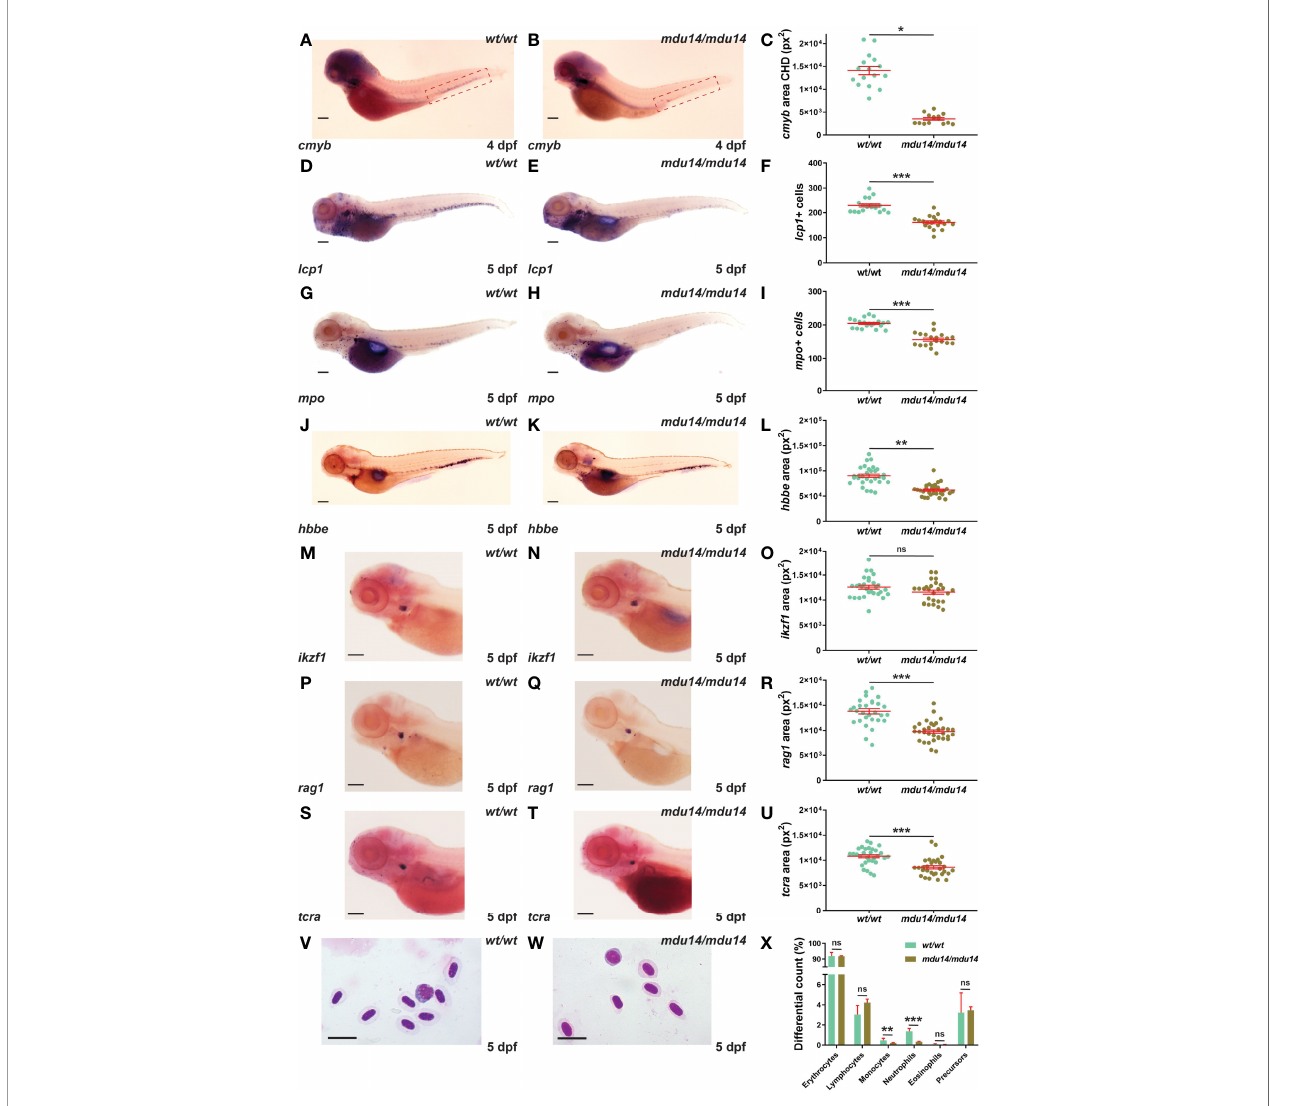
FIGURE 4 | Mutation of crlf3 impacts early de fi nitive hematopoiesis. (A – X) . Homozygous wild-type crlf3 wt/wt ( wt/wt ) and crlf3 mdu14/mdu14 ( mdu14/mdu14 ) embryos were subjected to WISH with cmyb (A, B) at 4 dpf, and lcp1 (D, E) , mpo (G, H) , hbbe (J, K) , ikzf1 (M – N) , rag1 (P, Q) and tcra (S, T) at 5 dpf (scale bar = 200 m m), or underwent blood analysis (V – W) at 5 dpf (scale bar = 10 m m). Individual embryos were assessed for the area of staining of cmyb CHD region (dotted boxes in panels A and B ) (C) , hbbe (L) , ikzf1 (O) , rag1 (R) and tcra (U) , as well as the number of lcp1 + (F) and mpo + (L) cells or for blood differential counts (X) , with mean and SEM in red and statistical signi fi cance indicated (*** p < 0.001, ** p < 0.01, * p < 0.05, ns, not signi fi cant). Welch ’ s correction was used for panels (C , L)